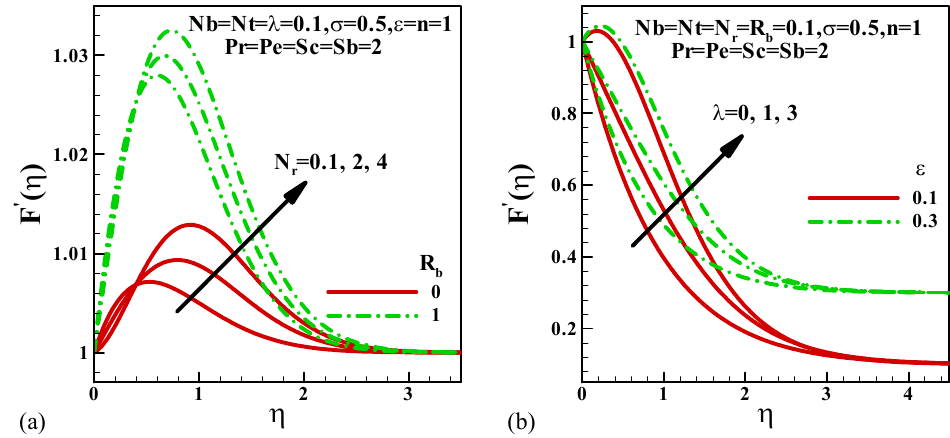
Figure 2. Variation of dimensionless velocity with ( a ) the buoyancy ratio parameter and bioconvection Rayleigh number and ( b ) the dimensionless mixed convection parameter and velocity ratio parameter.